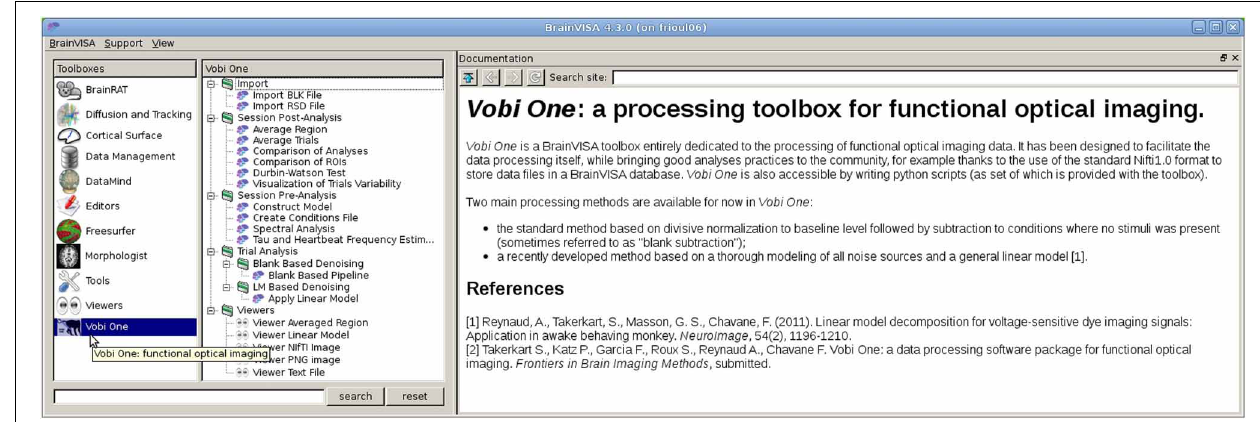
FIGURE 2 | The main Vobi One interface, as part of BrainVISA. Vobi One is listed and selected in the list of toolboxes in the left panel. The middle panels shows all the available processes . The right panel displays the associated